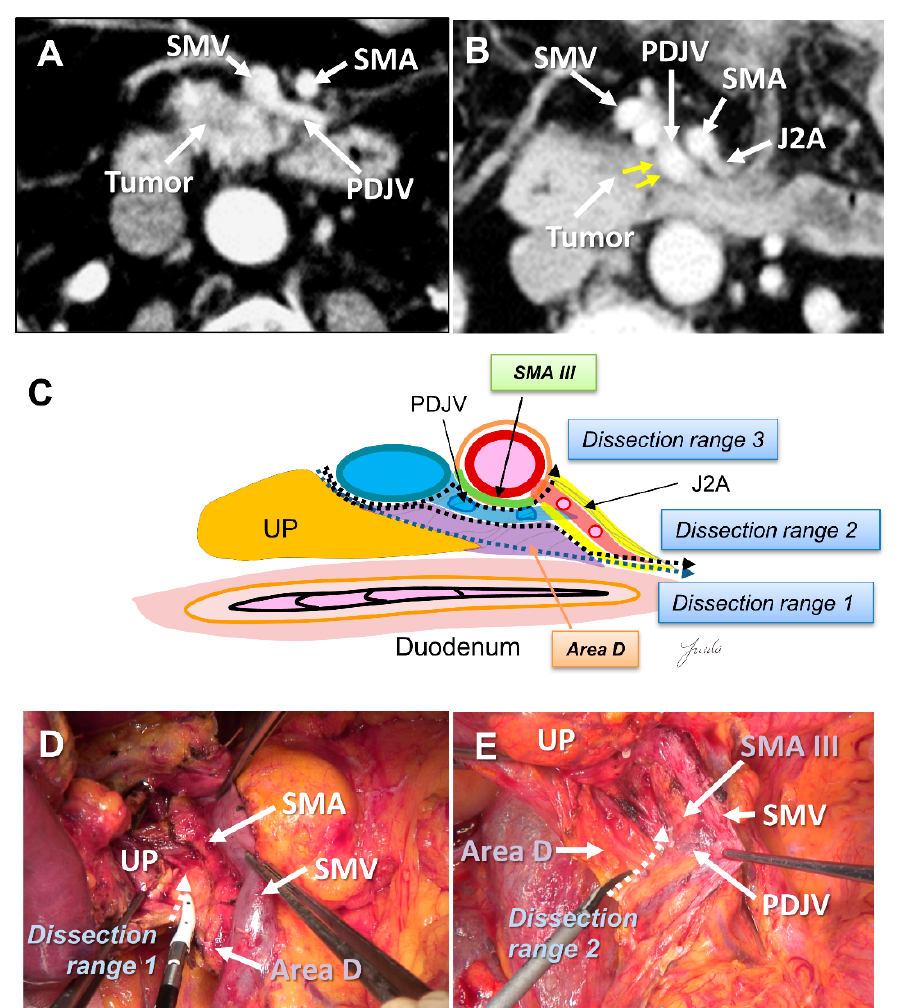
Figure 5. ( A ) Tumor extension on the dorsal side of the jejunal mesentery is not observed on the preoperative MDCT findings. ( B ) Tumor extension on the dorsal side of the jejunal mesentery is observed. ( C ) Determination of the dissection range based on the MDCT findings. Dissection ranges 1, 2, and 3 can be selected based on the anatomical structure, depending on the range of posterior infiltration. ( D ) Cutting line for dissection range 1. ( E ) Cutting line for dissection range 2. MDCT: multi-detector computed tomography; UP: uncinate process; SMA: superior mesenteric artery; SMV: superior mesenteric vein; PDJV: proximal dorsal jejunal vein; J2A: second jejunal